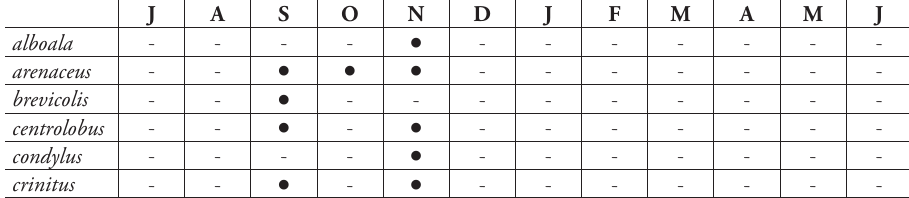
Table 1. Phenology of Gibbasilus species. Months, starting at July, abbreviated as